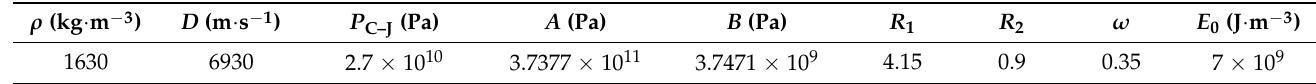
Table 3. Material parameters of the TNT charge [25].